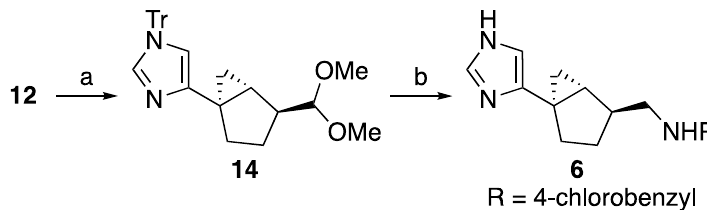
Table 1. Binding affinities of the compounds for the human H 3 and H 4 receptor subtypes.